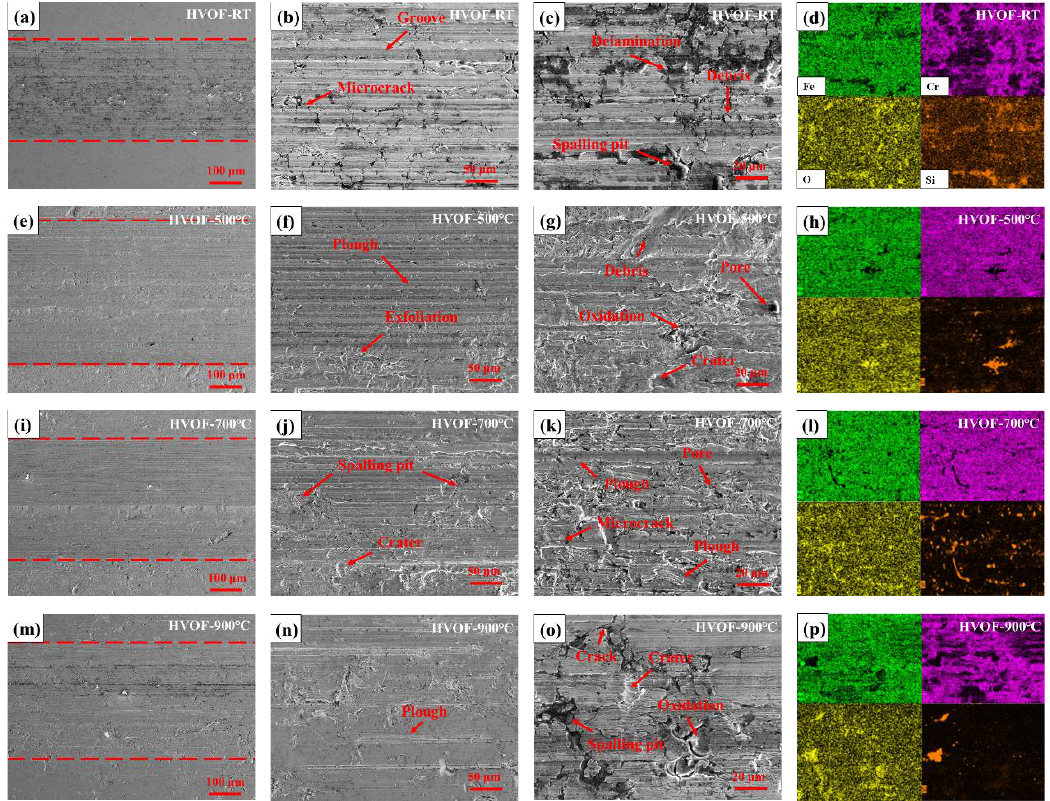
Figure 16. SEM wear morphology and EDS spectrum analysis of HVOF coatings under different heat treatment conditions. ( a – d ) HVOF-RT coating; ( e – h ) HVOF-500 °C coating; ( i – l ) HVOF-700 °C coating; ( m – p ) HVOF-900 °C coating.